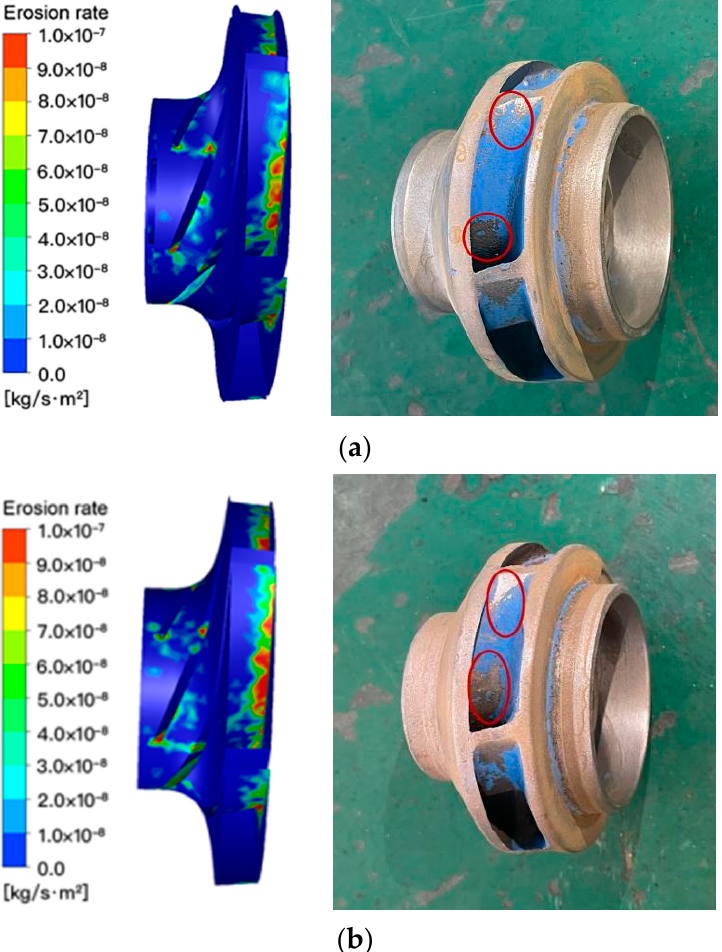
Figure 31. Comparison of numerical calculation results and test results of the erosion area under rated flow conditions: ( a ) first stage impeller; ( b ) secondary impeller.